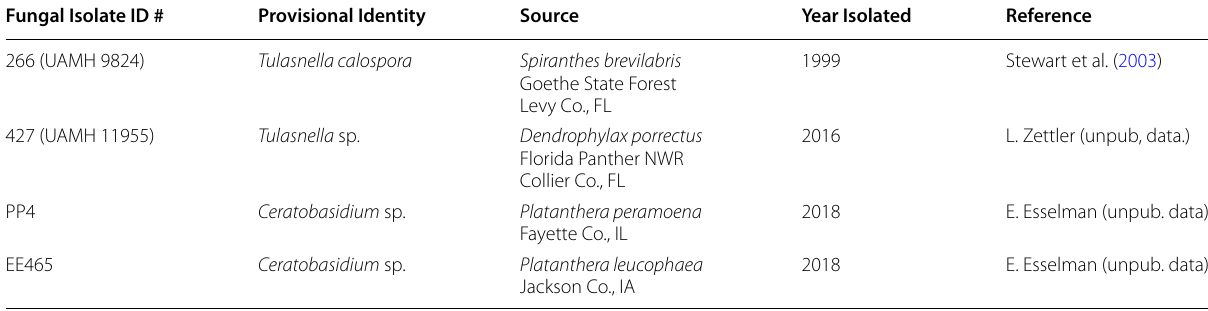
Table 1 The sources for the four strains of mycorrhizal fungi used in symbiotic germination of Spiranthes cernua Fungal Isolate ID